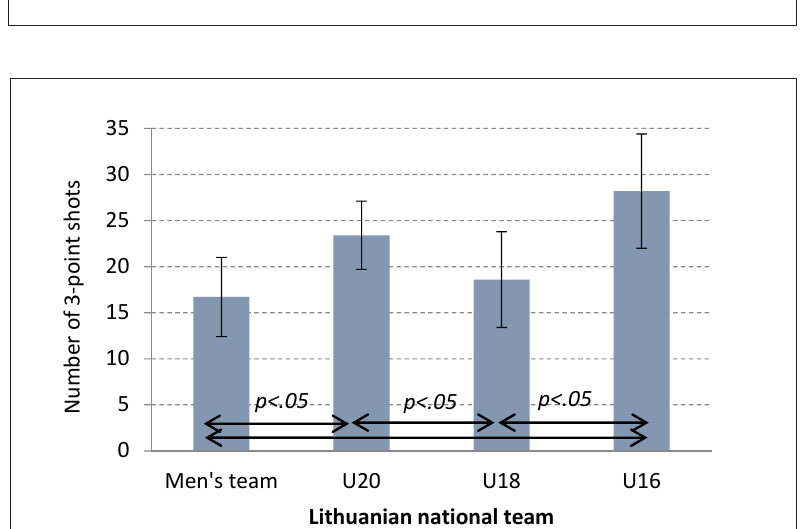
Figure 3. The number of 3-point shots for men’s basketball teams in the European championship matches (average per